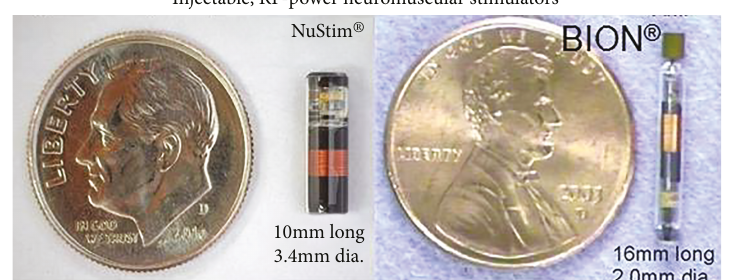
Figure 5: Two types of single-channel monolithic neuromuscular stimulators that can be implanted into individual muscles or near nerves, where they generate well-controlled stimulus pulses that are powered and commanded by an externally generated radio-frequency magnetic fi